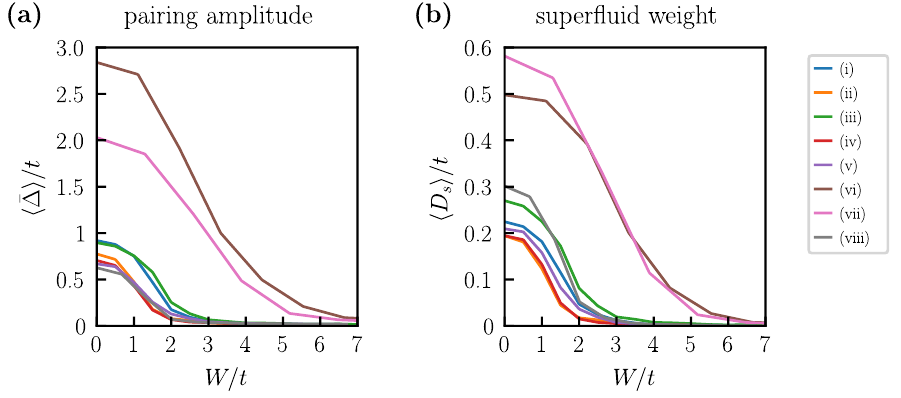
Figure 12: Disorder-induced suppression of the pairing amplitude and the superfluid weight across a variety of lattice models corresponding to Fig. 1 of the main text: (i)- (v) topological and trivial extended Kane-Mele models, (vi)-(viii) trivial single-band models. The ensemble averages of (a) the spatial average of the pairing amplitude ¯ ∆ and (b) the superfluid weight D are shown as a function of the disorder strength s W . In contrast to Fig. 1 of the main text, we here show the unscaled quantities in units of the nearest-neighbor hopping amplitude t of the respective